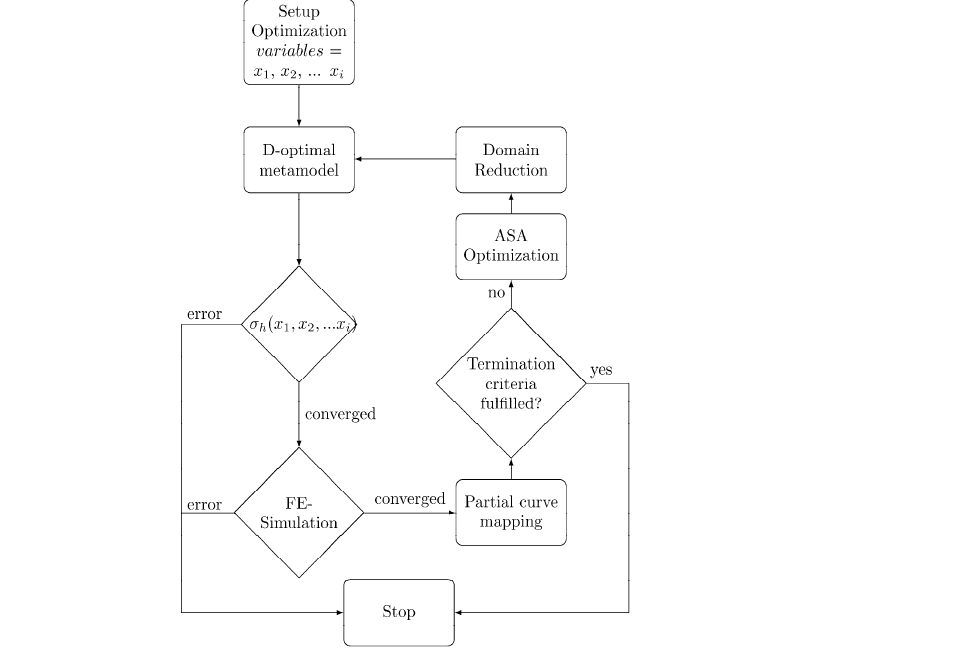
Figure 2. Optimization routine in LS-OPT 6.0.0 using an FE simulation in LS-DYNA of the dog bone tensile specimen and a user-defined HC σ h to minimize the difference between the simulated and the experimental force–displacement curve.